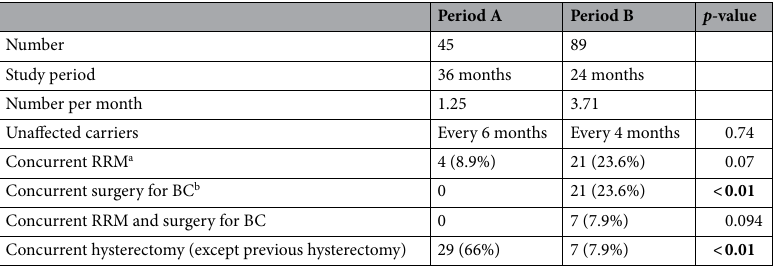
Table 2. Outcomes of risk-reducing salpingo-oophorectomy. a Risk-reducing mastectomy. b Breast cancer.